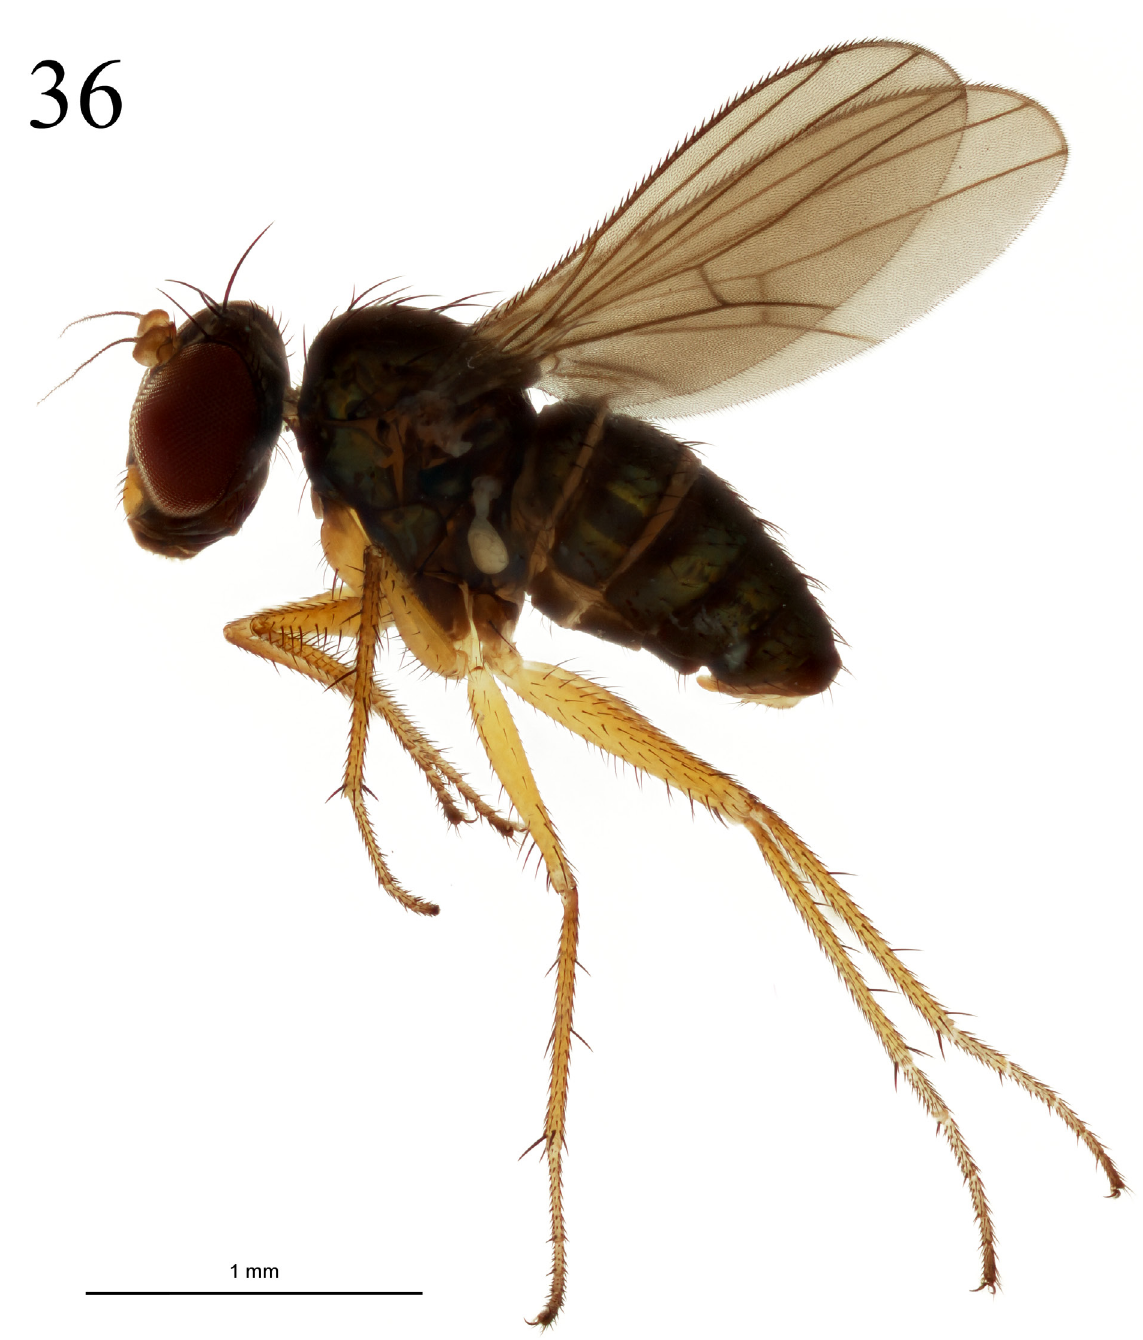
Fig. 36. Thinophilus variabilis sp. nov., ♂,